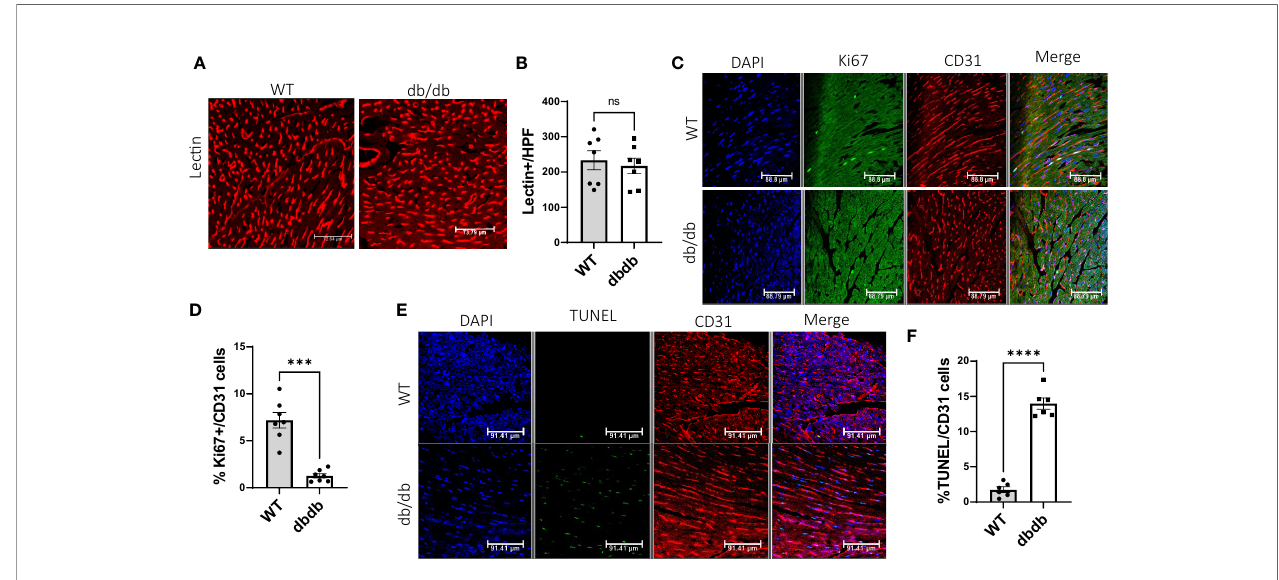
FIGURE 5 | Comparison of cardiac angiogenesis, endothelial proliferation, and apoptosis between WT-hearts and db/db-hearts. (A) Immuno fl uorescent staining of lectin to detect capillary density in WT-hearts and db/db-hearts; (B) Comparison of Lectin-positive cells per high power fi eld (HPF) between WT-hearts and db/db hearts (ns, P >0.05, n=7); (C) Immuno fl uorescent staining of Ki67 and CD31 to detect proliferative endothelial cells in WT-hearts and db/db-hearts; (D) The comparison of the percentage of Ki67 + endothelial cells between WT and db/db hearts (***P < 0.001, n=7); (E) Immuno fl uorescent staining of TUNEL and CD31 to detect apoptotic endothelial cells in WT-hearts and db/db hearts; (F) The comparison of the percentage of TUNEL-positive endothelial cells between WT and db/db hearts (****P < 0.0001,